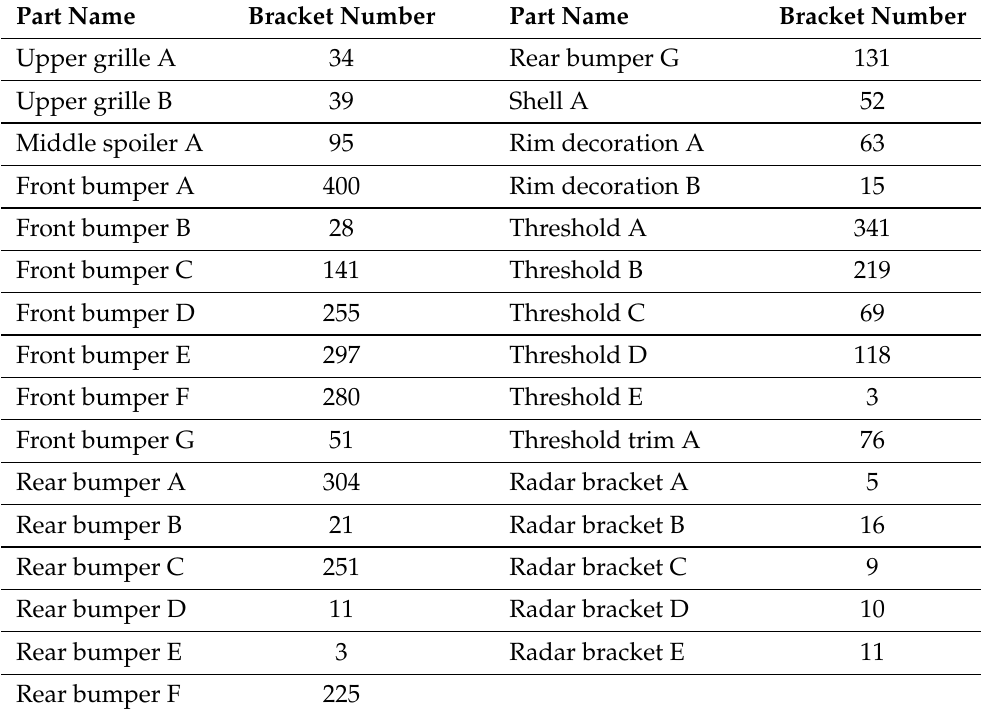
Table A3. The number of bracket for different types of